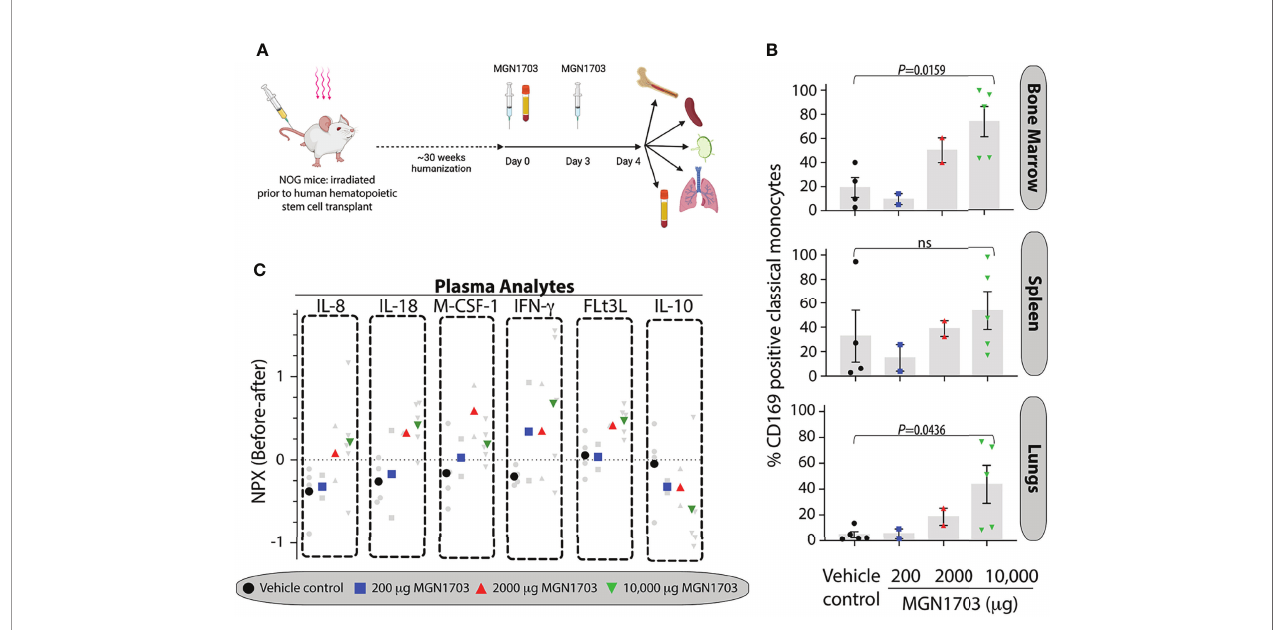
FIGURE 2 | In vivo immunomodulatory impact on human monocytes of TLR9 agonist in humanized NOG mice. (A) Schematic depiction of humanized NOG mice experiment. Humanized NOG mice were dosed with MGN1703 in one of 3 different dosage groups (200, 2,000 and 10,000 m g/mouse) or with physiological saline on day 0 and day 3. Blood collection was performed at baseline and at the time of necropsy on day 4, where bone marrow, spleen, lymph nodes and lungs were collected as well. Graphic created with Biorender. (B) Tissue cells were isolated on day 4 from bone marrow, spleen, and lungs. These cells were evaluated for CD169 expression using fl ow cytometry. Percentages of CD169 positive classical monocytes are depicted in the bar graphs. Individual mice values are shown together with each bar that depicts the mean (+/- SEM). Data were analyzed by ANOVA and MGN1703 dose groups were compared with vehicle group using Dunnets multiple comparison tests. (C) Cytokines and chemokines in day 4 plasma were analyzed relative to baseline using O-link technology. Individual mice normalized protein expression (NPX) values are depicted as changes from baseline in light grey with the dose-group average denoted by large colored